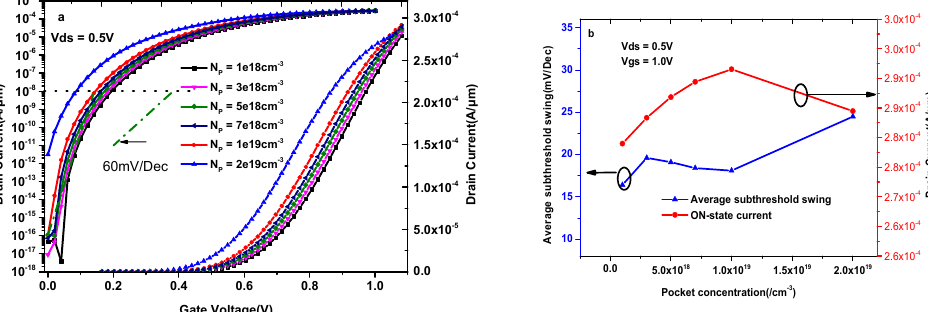
Figure 8. ( a ) Transfer characteristics of DMG-HD-VTFET with different source-pocket concentration; ( b ) the variation of ON-state current and average subthreshold swing (SS ave ) with different source-pocket